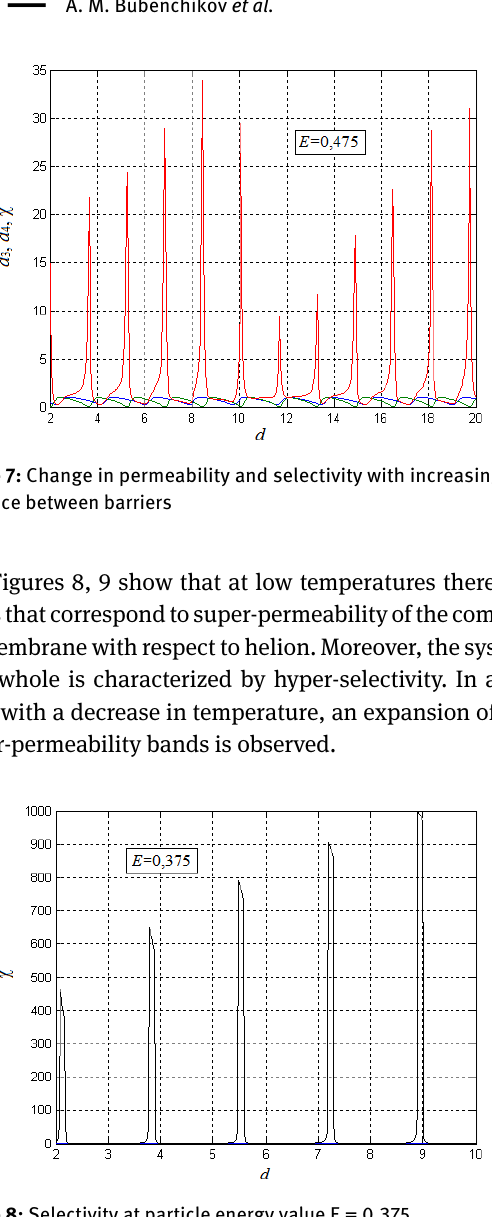
Figure 8: Selectivity at particle energy value E = 0.375